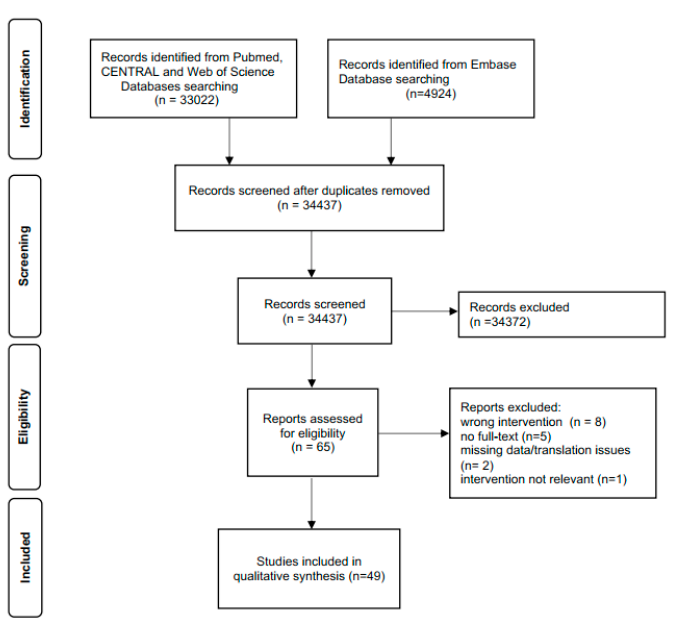
Figure 1. PRISMA Flowchart.